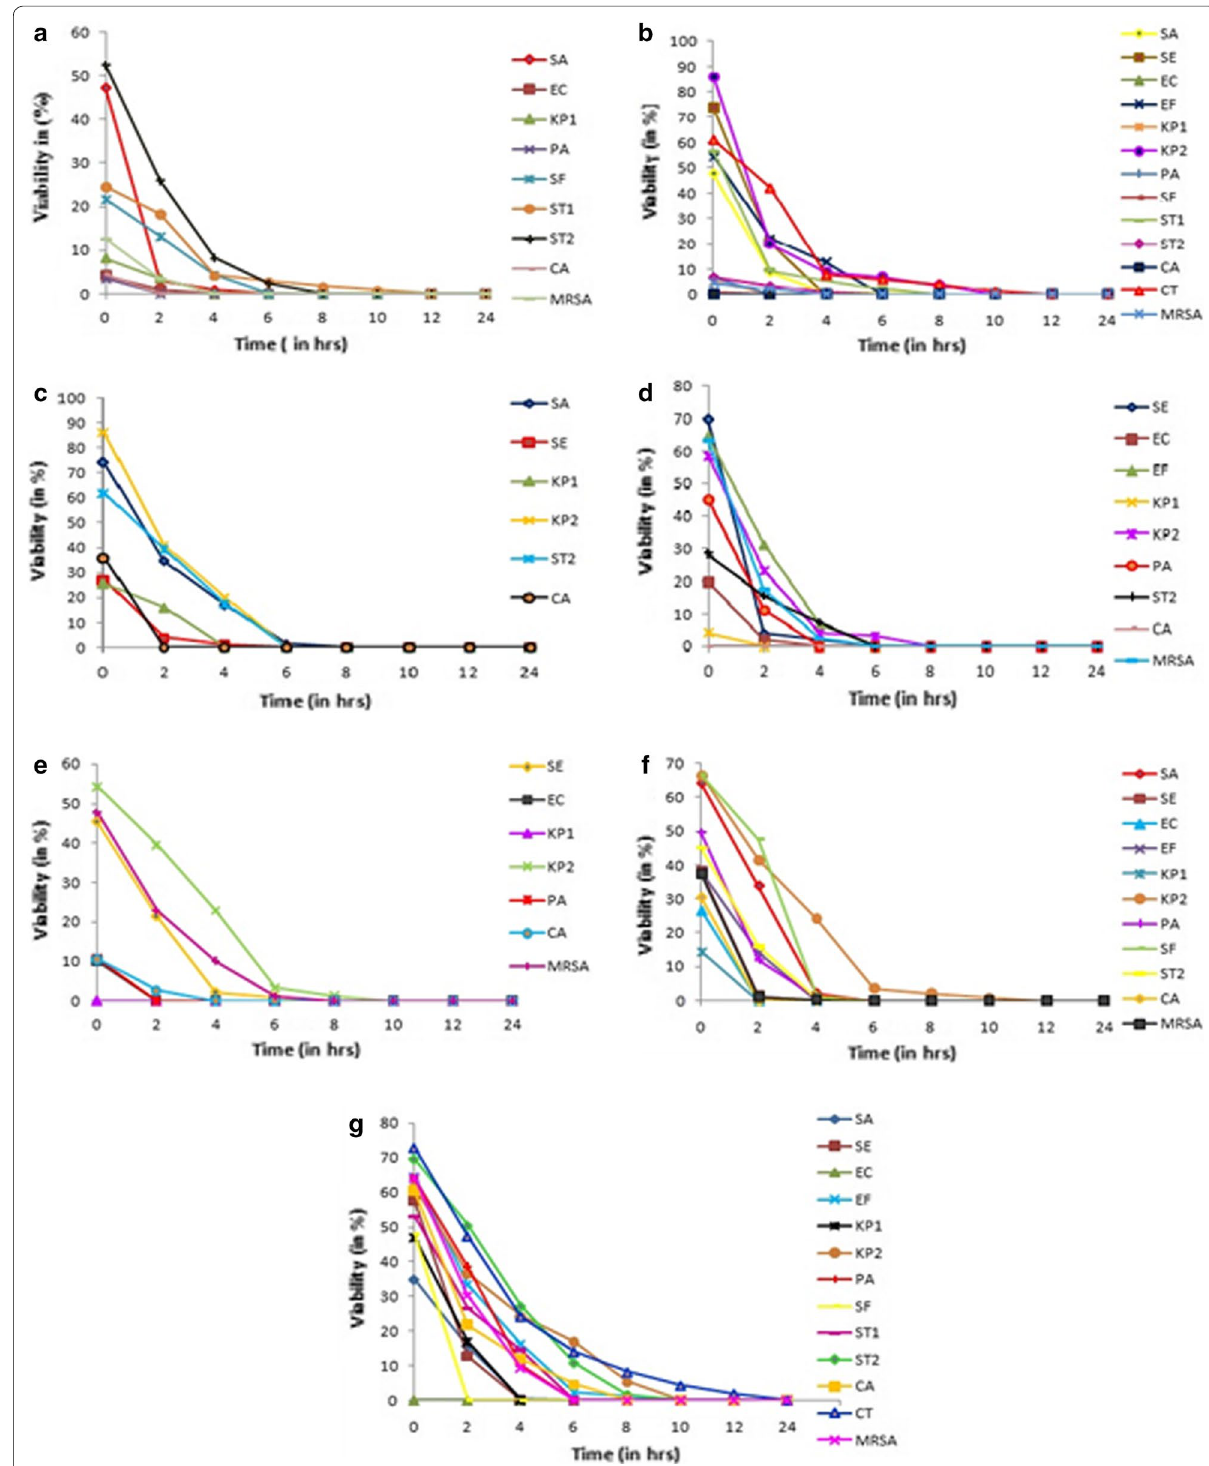
Fig. 2 Viable cell count (VCC) studies for a Aqueous extract b Organic extract c Alkaloids d Flavonoids e Saponins f Cardiac glycosides of Gymnema sylvestre leaves and g Standard antibiotic Gentamicin (*Amphotericin B for yeast strains). SA, Staphylococcus aureus ; SE, Staphylococcus epidermidis ; EC, Escherichia coli ; KP1, Klebsiella pneumoniae 1; KP2, Klebsiella pneumoniae 2; SF, Shigella flexneri ; ST1, Salmonella typhimurium 1; ST2, Salmonella typhimurium 2; PA, Pseudomonas aeruginosa ; CA , Candida albicans ; CT, Candida tropicalis ; MRSA, Methicillin-resistant Staphylococcus